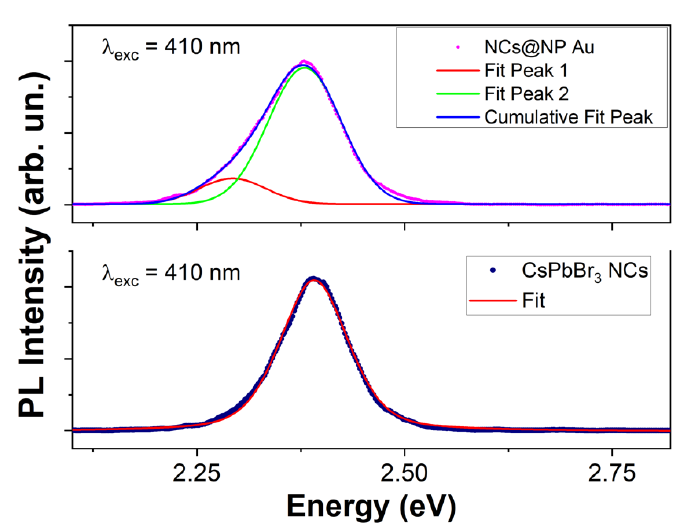
ture compared to the emission of the pure CsPbBr 3 NCs.